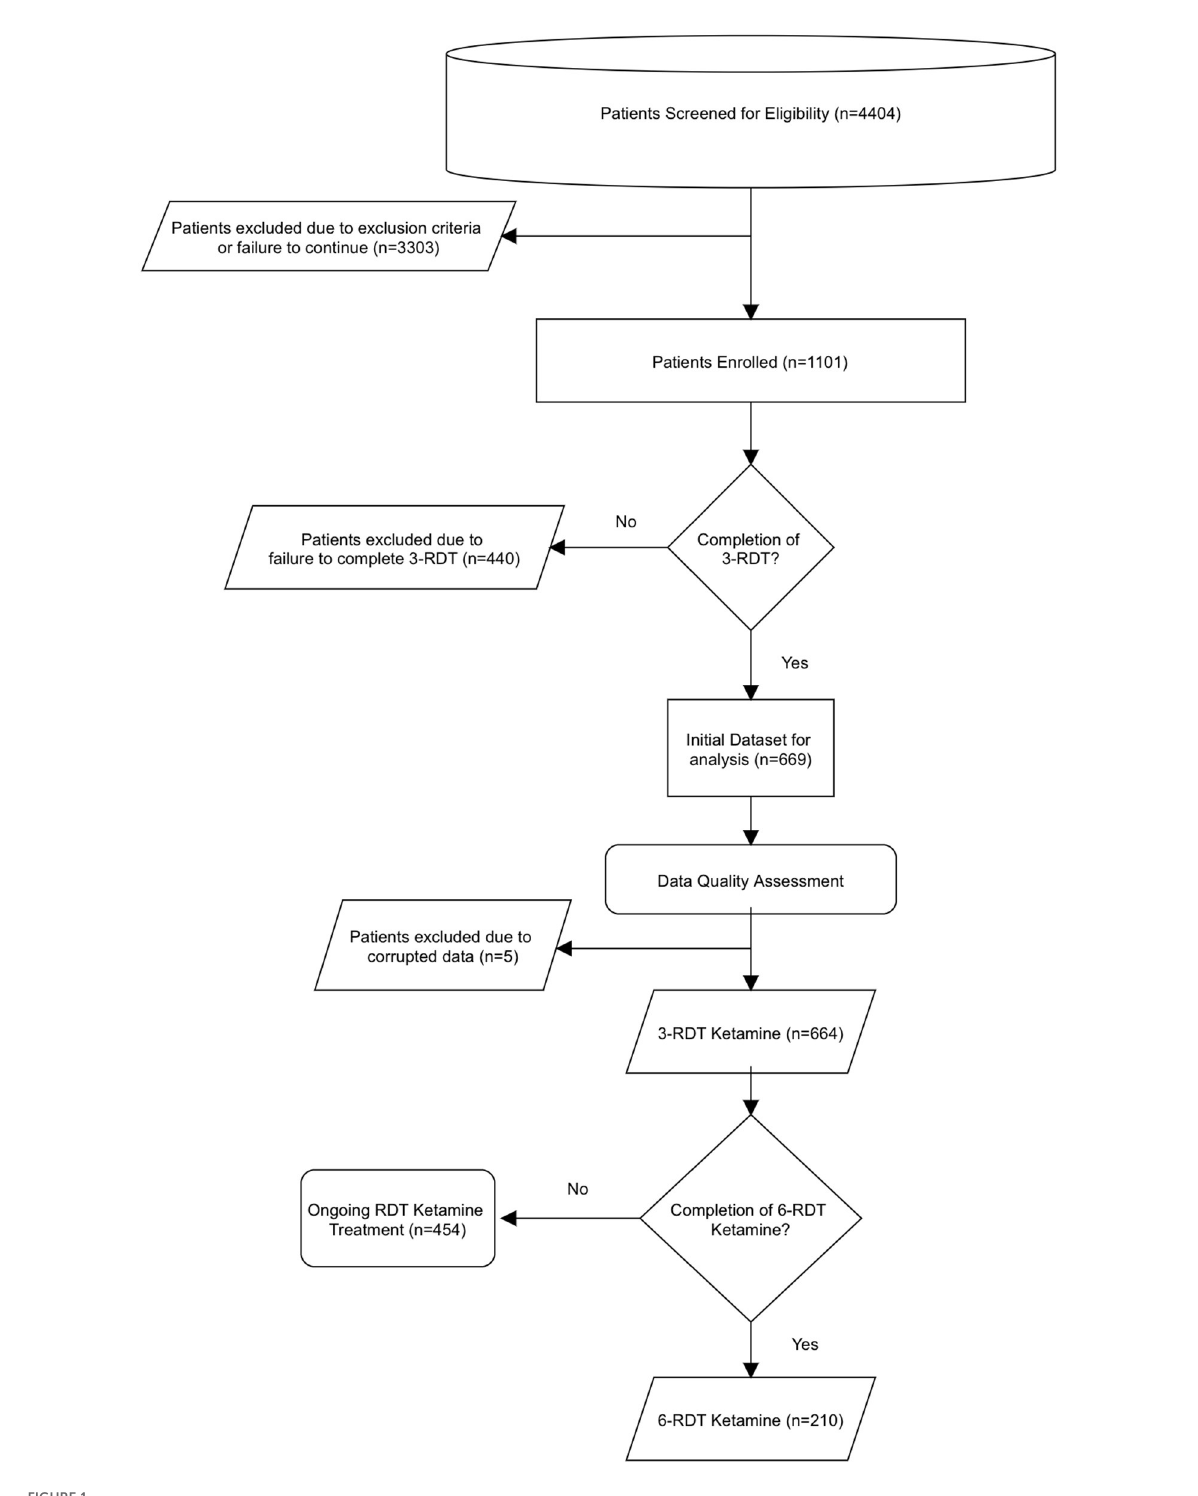
FIGURE1 Dataset and process